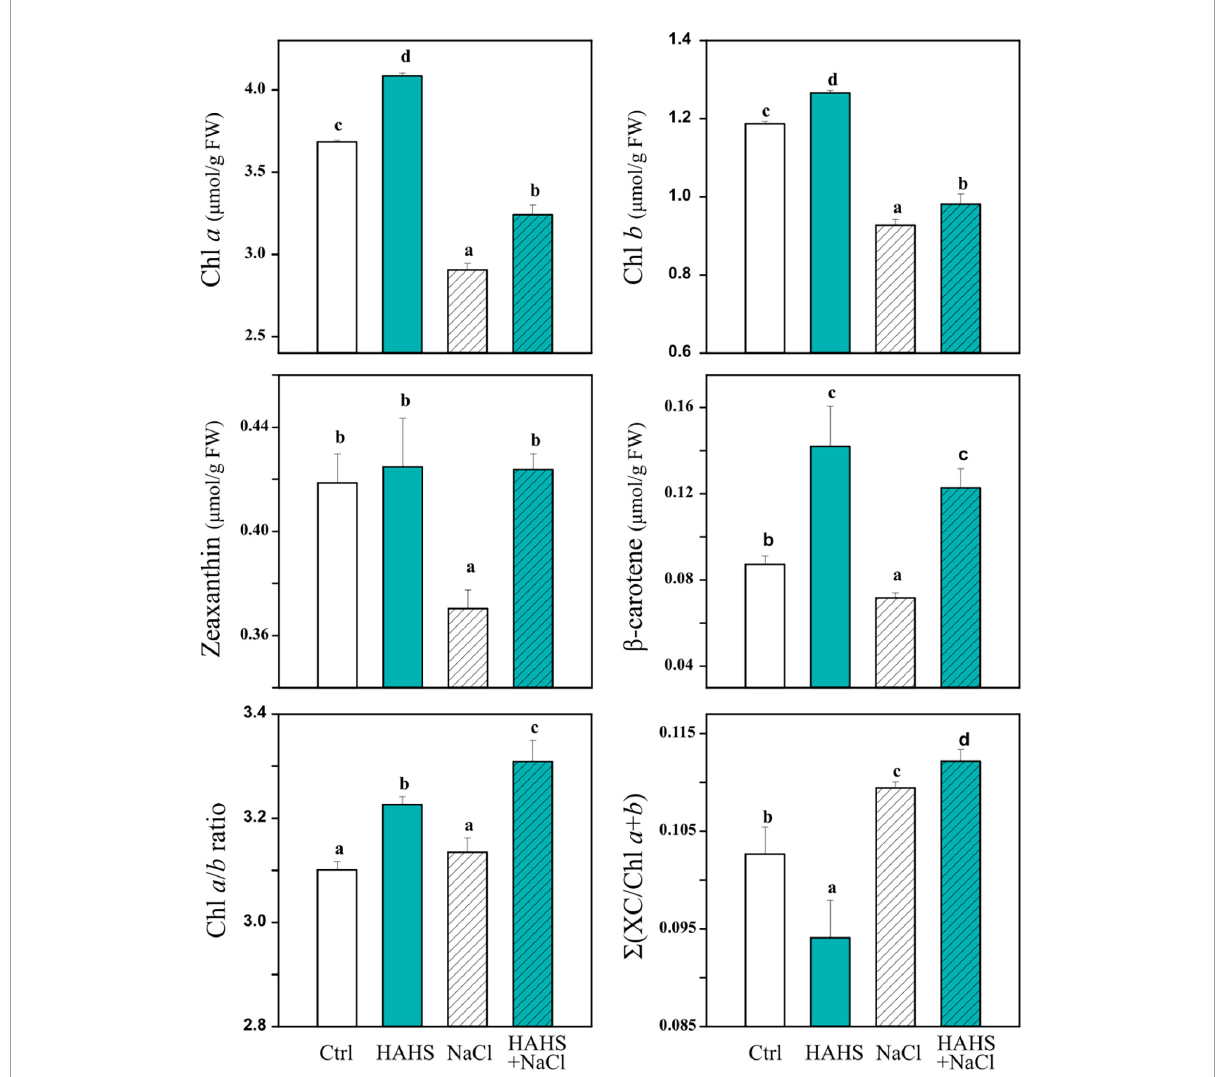
FIGURE6 Salinispora arenicola induces changes in photosynthetically related pigments under normal and saline conditions. Plants ( n = 4) 39 days after germination (DAG) were grown with either normal irrigation (white boxes) or saline irrigation (NaCl; gray boxes) and inoculated with a habitat-adapted heterologous symbiont (HAHS; B, turquoise) or not (control; C, black). Statistical significance was determined separately for each irrigation scheme using a univariate analysis of variance (ANOVA; p = 0.001). Lowercase letters denote statistical differences (pairwise test) among conditions.